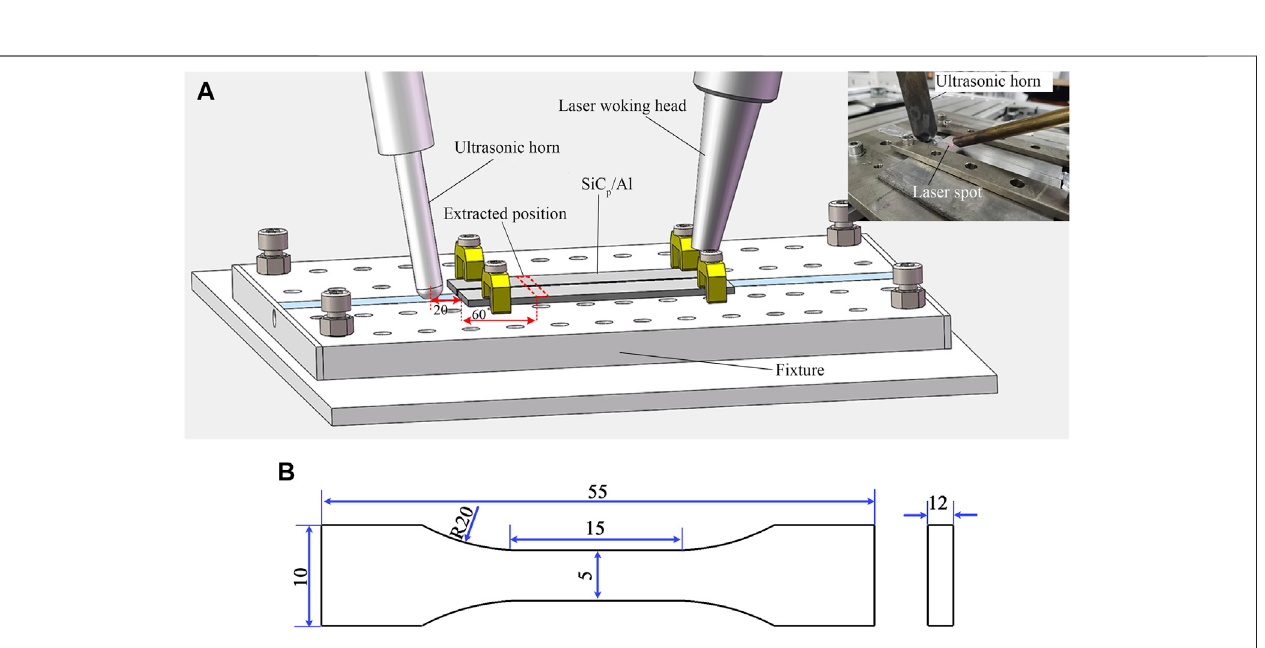
Figure 3A . Stereo microscope, optical microscope and